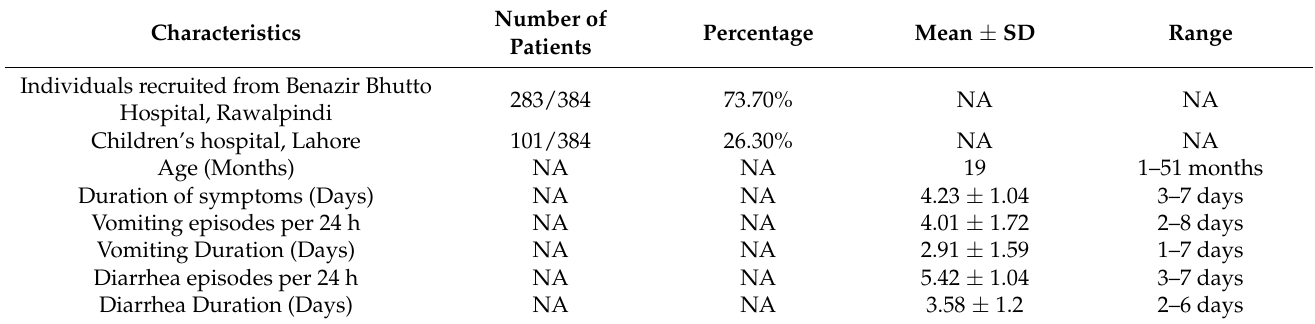
Table 1. Number and percentage of individuals recruited from two hospitals, their demographic and clinical